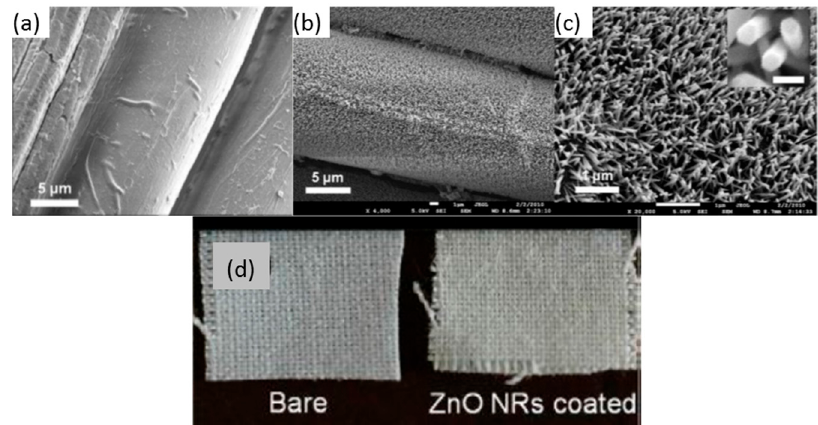
Figure 22. Cotton fibres ( a ) before and ( b ) after the ZnO deposition; ( c ) detailed of the coating structure formed by hexagonal shaped columns (see image inside); ( d ) fabric with no ZnO and another coated one. Reprinted from [102] and used with permission from Elsevier.